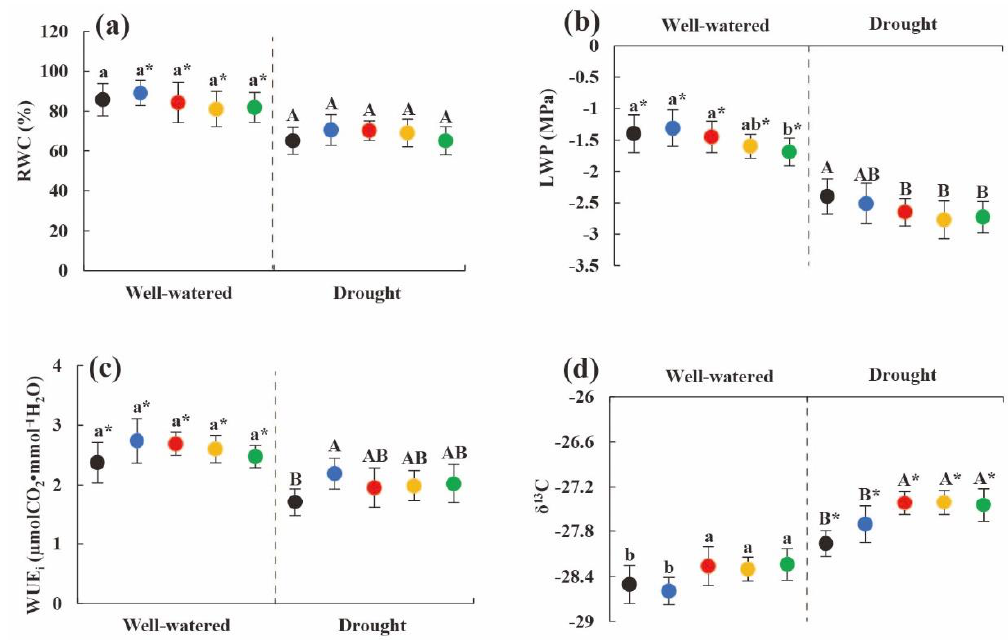
Figure 3. Changes in moisture content and utilization efficiency of heteromorphic leaves with tree height under different soil moisture conditions. Note: ( a – d ) were changes in relative water content, leaf water potential, instantaneous water use efficiency, stable carbon isotope value with different tree heights under different soil moisture condition. The black dot indicates the height of the 2 m tree, the blue dot indicates the height of the 4 m tree, the red dot indicates the height of the 6 m tree, the yellow dot indicates the height of the tree 8 m, and the green dot indicates the height of the 10 m tree; lowercase and uppercase letters represent the significance of the difference between different sampling heights under suitable soil moisture conditions and soil drought stress conditions, and * represents the comparison of the same height under different habitats ( p < 0.05). RWC: relative water content; LWP: leaf water potential; WUE i : instantaneous water use efficiency; δ 13 C: stable carbon isotope value.